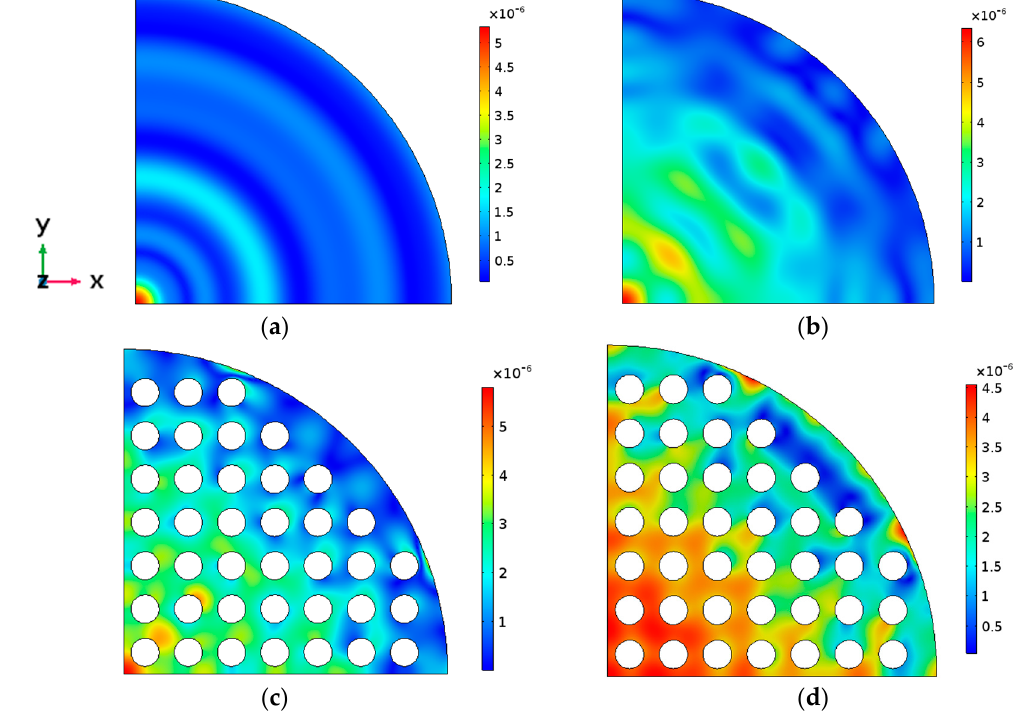
Figure 4. The z direction vibration amplitude calculated at the aluminum surface for the four models at their respective main thickness resonance (one wavelength resonance). ( a ) Model 1, ( b ) Model 2, ( c ) Model 3 and ( d ) Model 4. The excitation voltage of the piezoceramic disc in all the models was 1V. The bar scale is in mm. The frequency for each model was 997 kHz, 951 kHz, 988 kHz and 894 kHz, respectively.